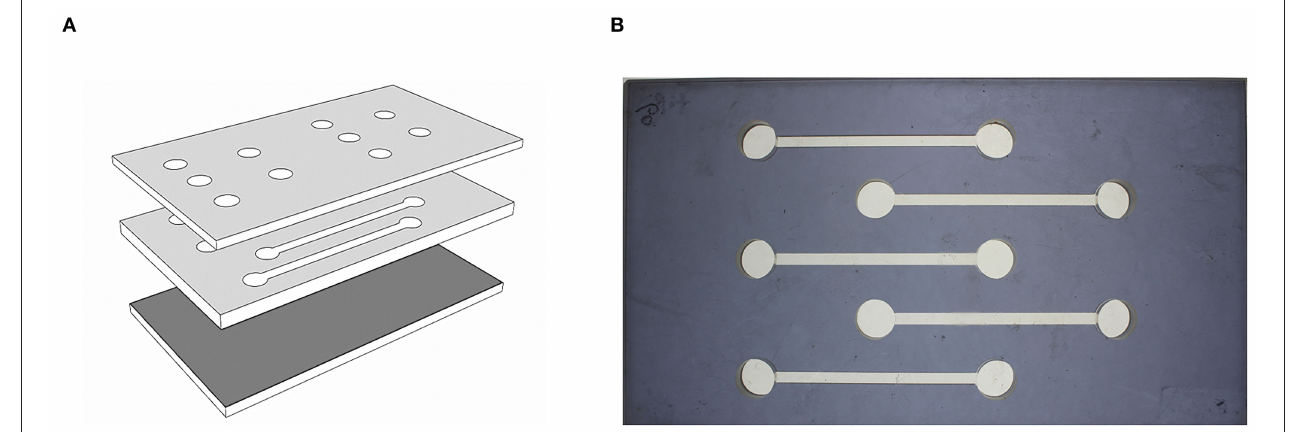
FIGURE 1 | Experimental arena used in behavioral assay. (A) The planar arena composed of three layers (top, middle and bottom layer). The top layer contain introduction hole, middle layer produce tunnel and bottom layer. (B) Top view of the planar arena.